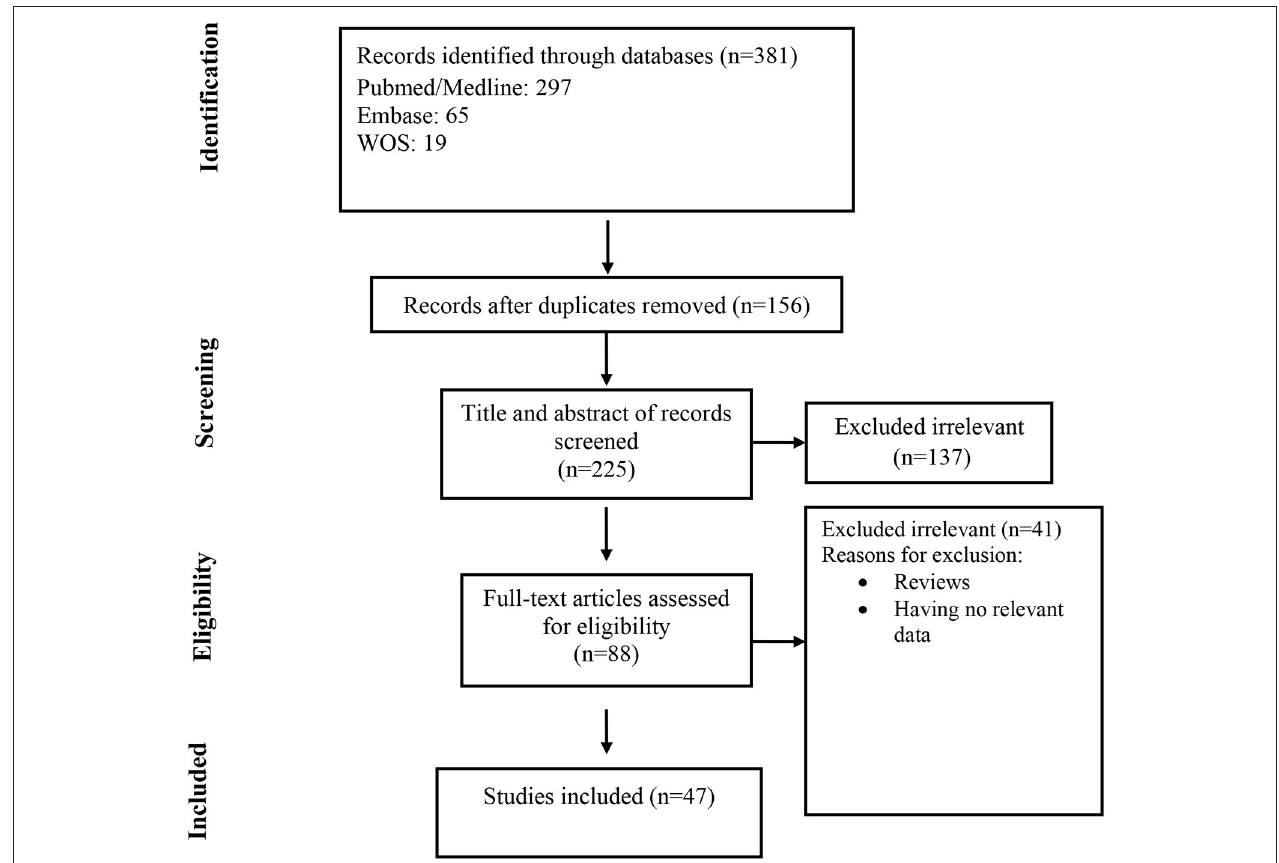
FIGURE 1 | Flow chart of study selection for inclusion in the systematic review and